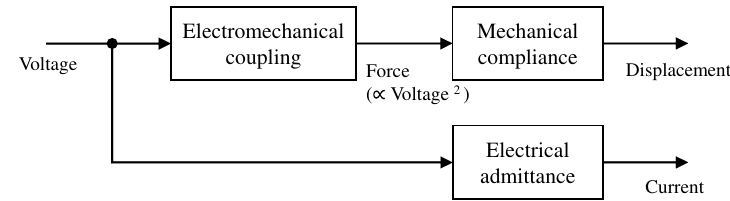
Figure 5. Structure of the model of a